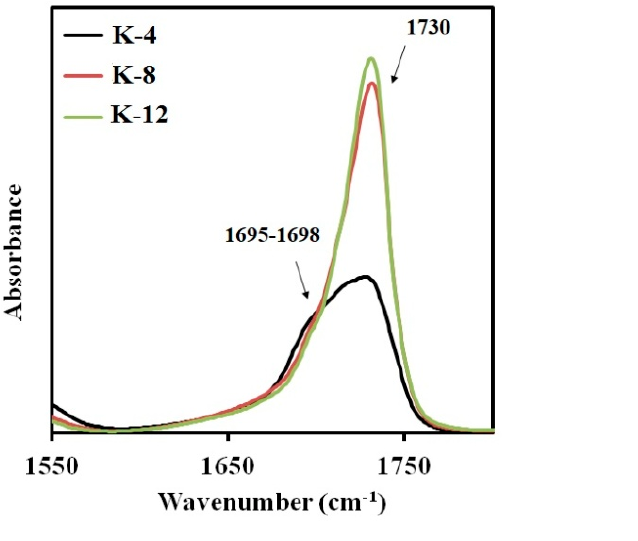
( b ) Figure 7 . Sections of the FTIR spectra for the samples: ( a ) K–2, K–6, K–10; ( b ) K–1, K–5, K–9. For the elastomers with hard urethane hydroxyl segments based on isophorone diisocyanate, the absorption band characteristic for the microphase separation is ob- served in the range of 1695–1698 cm –1 [28]. In Figure 8a,b the FTIR spectra sections are presented for the elastomers prepared using isophorone diisocyanate and cured with aminoethylpiperazine (Figure 8a) or isophorone diamine (Figure 8b). In all spectra, the two absorption bands can be easily distinguished: at 1730 cm − 1 and at 1695–1698 cm − 1 . When using aminoethylpiperazine, the highest degree of SS-HS microphase separation is achieved at the soft segment molecular weight of 991. Further increase in the soft seg- ment molecular weight results in a lower degree of microphase separation. At the same time, structural phase organization in the elastomers K-8 and K-12 is similar.